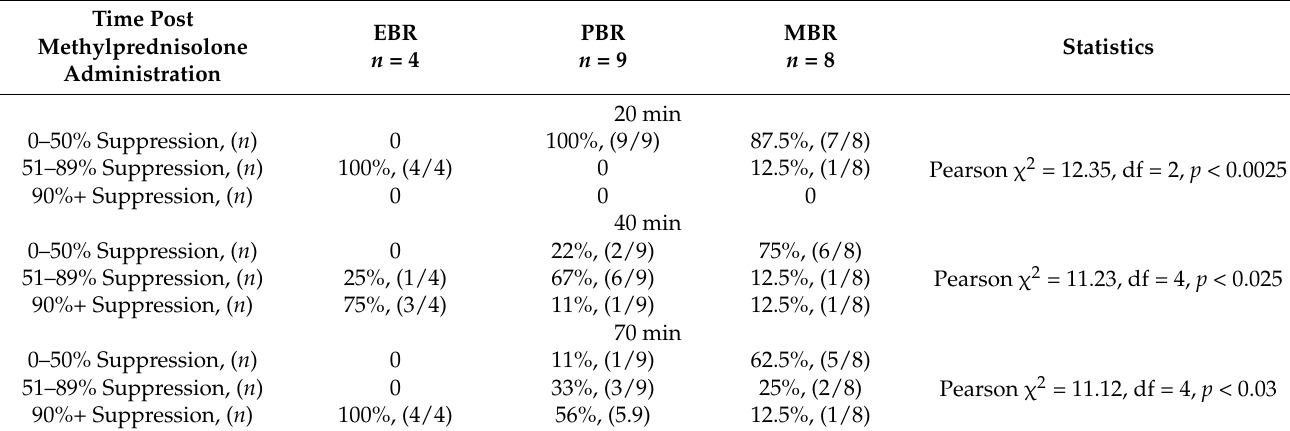
Table 1. The percentage of corticosterone suppression at 20, 40 and 70 min after methylprednisolone administration. Time Post